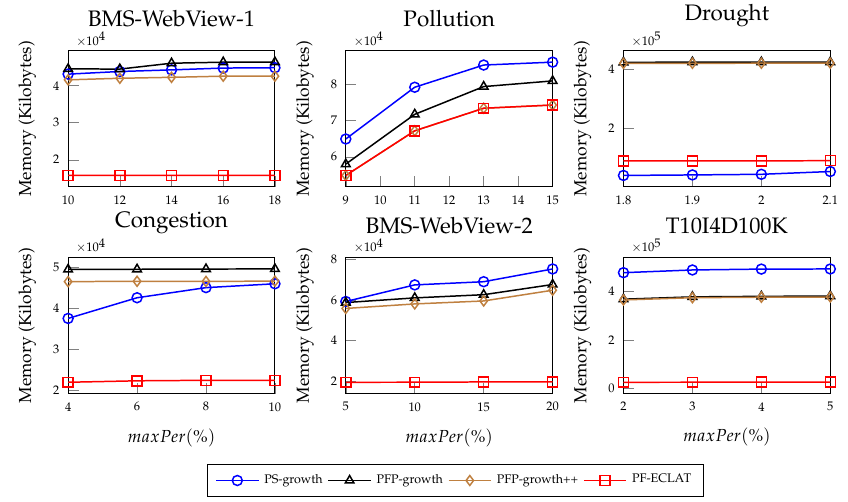
Figure 5. Memory evaluation of algorithms at constant minSup .